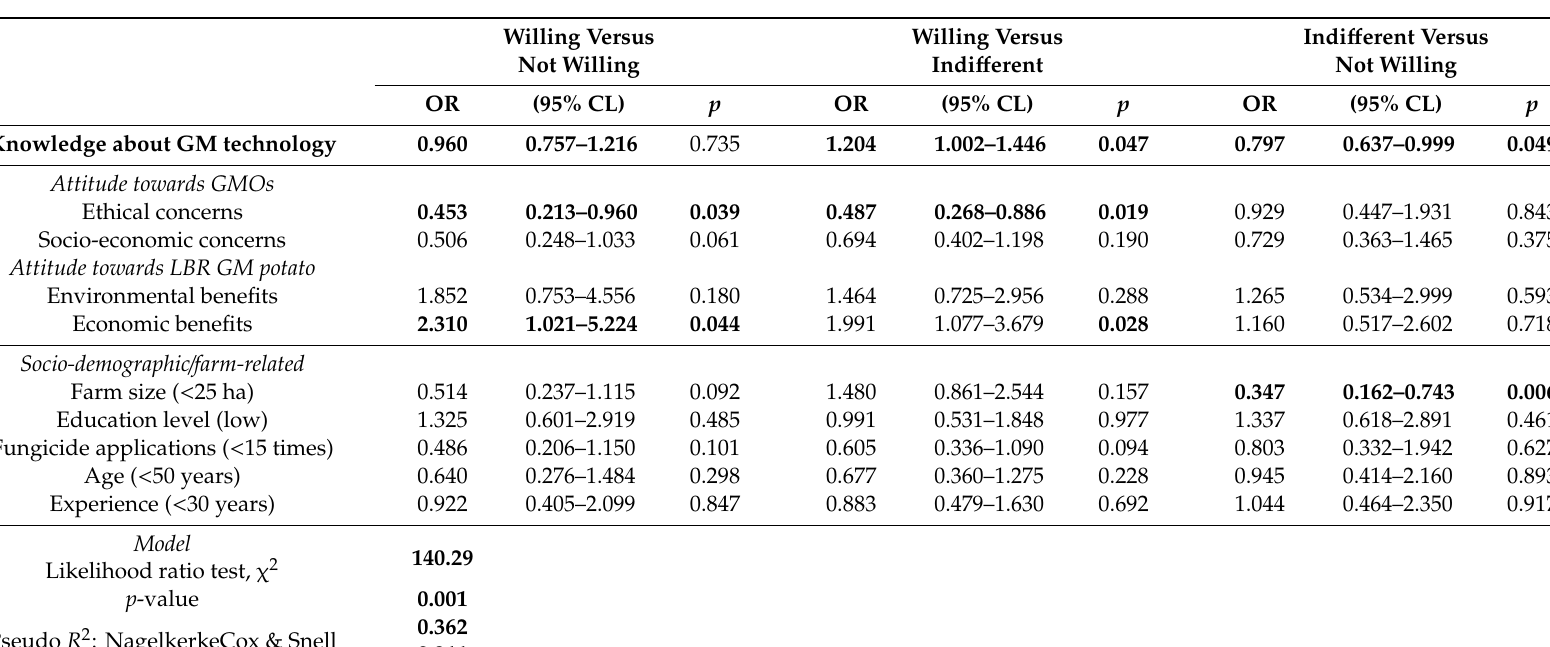
Table 4. Determinants of farmers’ willingness to adopt cultivation of the LBR GM potato, by multinomial logistic regression ( n = 377). Willing Versus Willing Versus Indi ff erent Versus Not Willing Indi ff erent Not Willing OR (95% CL) p OR (95% CL) p OR (95% CL)